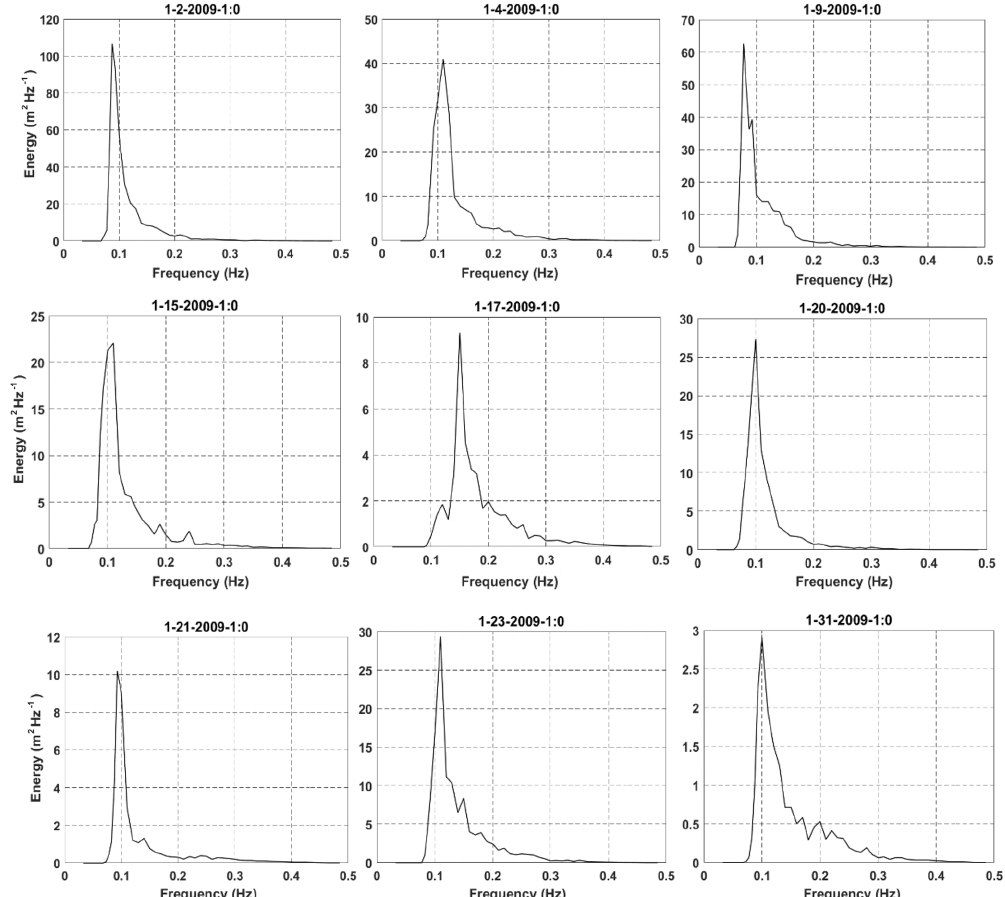
Figure 3. Examples of single-peaked frequency spectra measured at NDBC 44011 in January 2009. The title for each panel shows the date and time of measurement with the format month–day–year–hour: